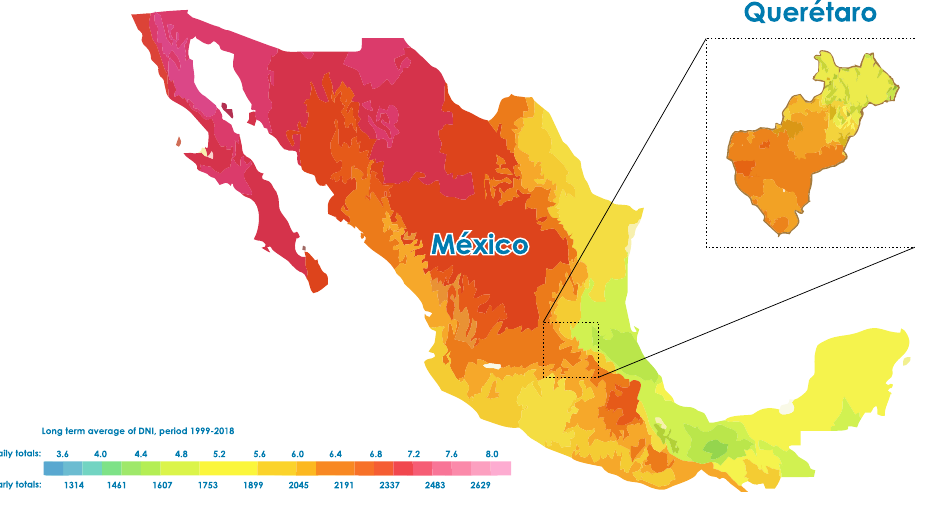
Figure 1. Solar atlas map of Mexico